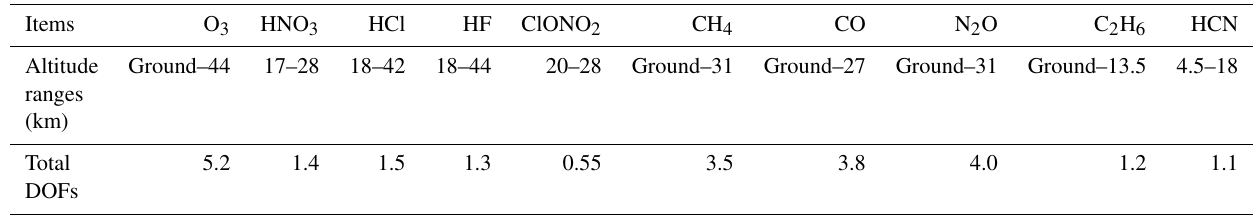
Table 3. Altitude ranges with sensitivities larger than 0.5 for all NDACC gases. Items O 3